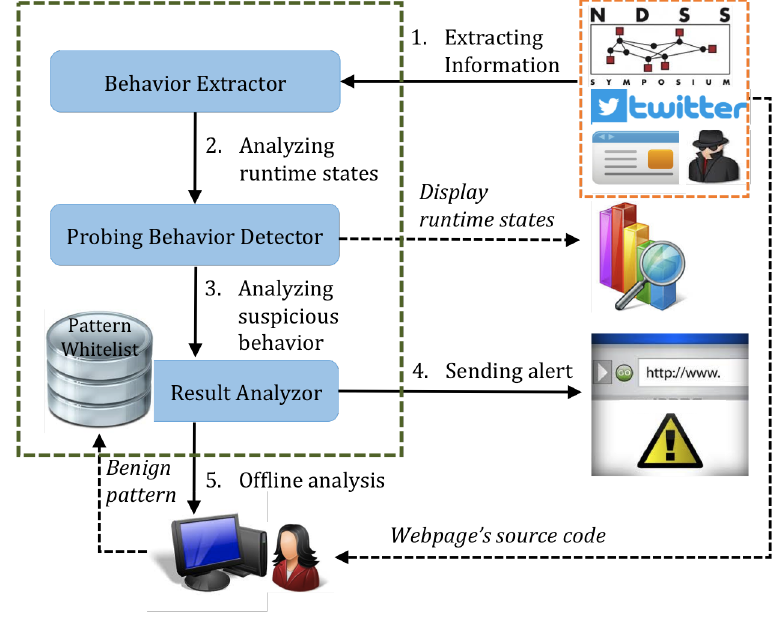
Figure 2. Architecture of our